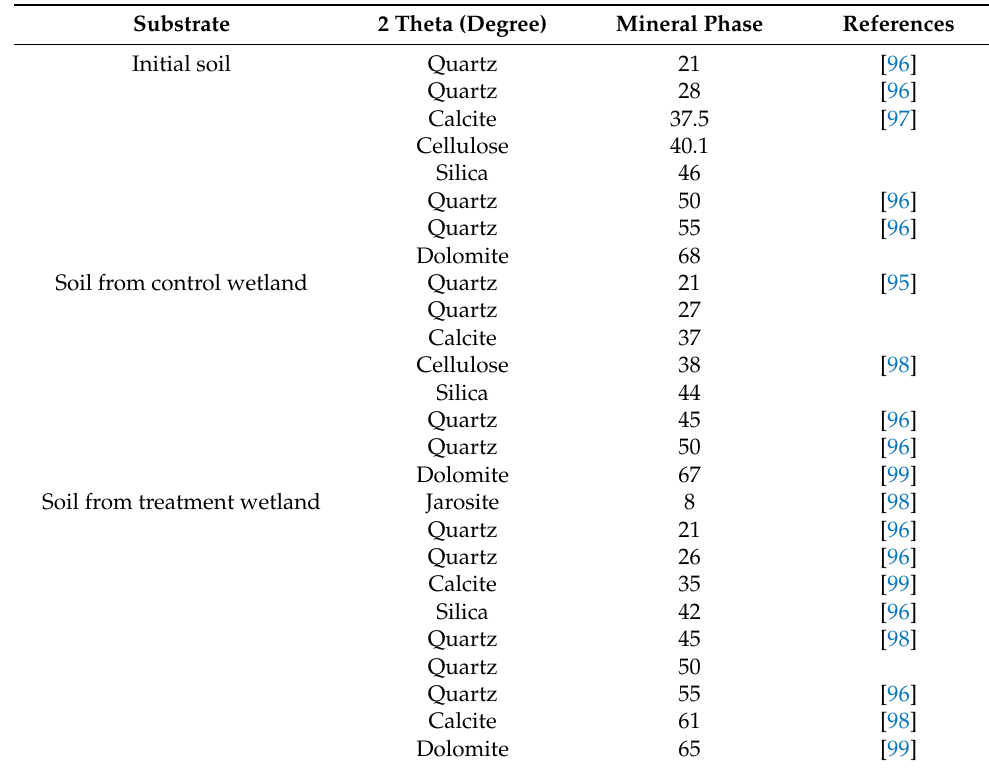
Table 4. The measured XRD and the identified mineral phase of the initial substrate, substrate from experimental wetland, and substrate from control wetland.